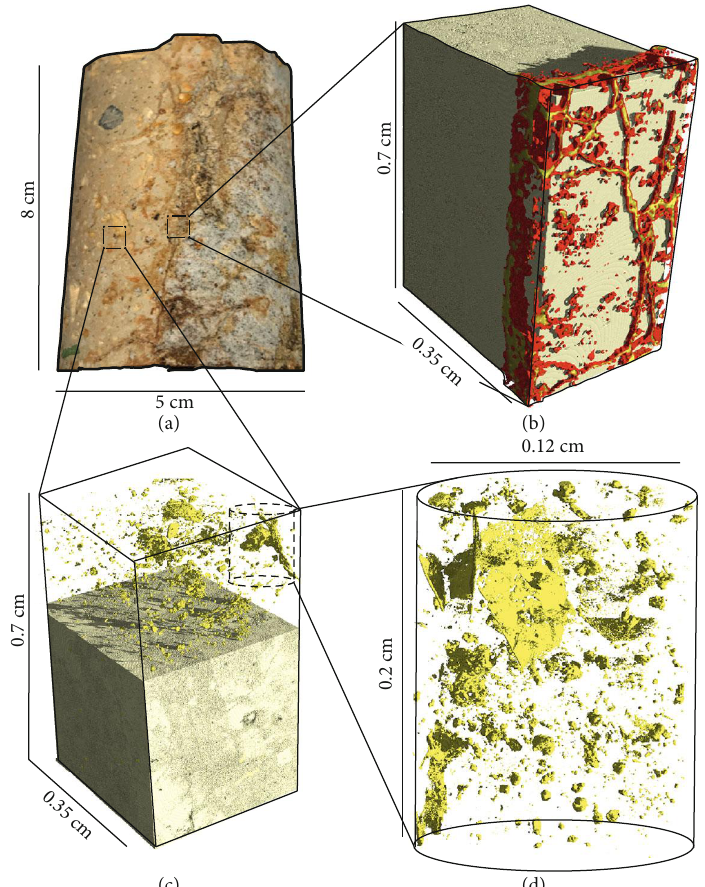
Figure 9: 3D reconstruction of the matrix and fractures of a sample from the Peyrouses 1 borehole. Fractures are shown in red and voids in yellow. The resolution of these images is 10, 10, and 2.5 μ m ((b – d),